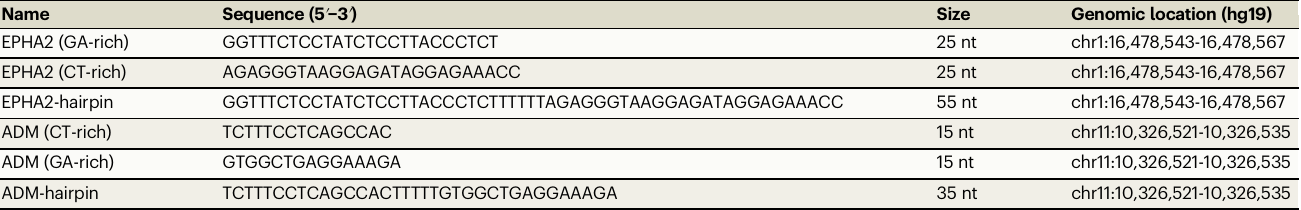
Table 2 | DNA oligos used for 1 H-1D NMR, CD and melting curve analysis